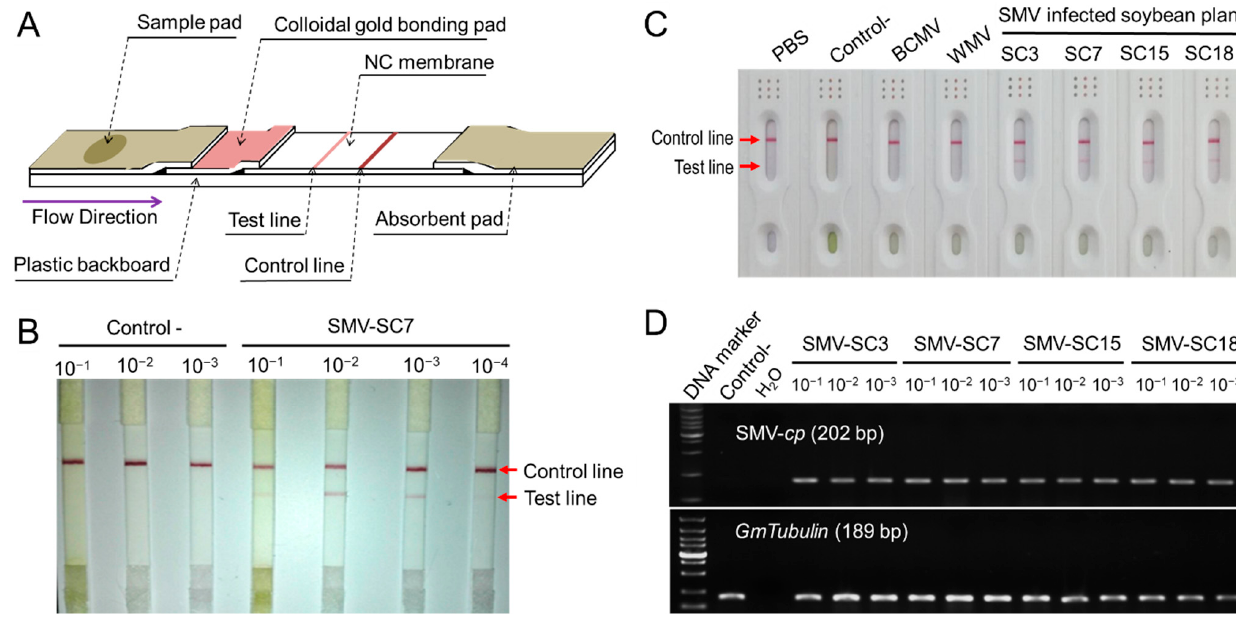
Figure 7. Development, sensitivity and specificity test, and field application of the SMV-GICS. ( A ) The schematic representation of the SMV-GICS; ( B ) sensitivity test of the SMV-GICS in detection of SMV present in the gradient-diluted crude extract of leaves infected with SC7; ( C ) specificity test of the SMV-GICS in detection of SMV, BCMV and WMV; ( D ) detection of SMV present in the leaves infected with SC3, SC7, SC15 and SC18 using RT-PCR.